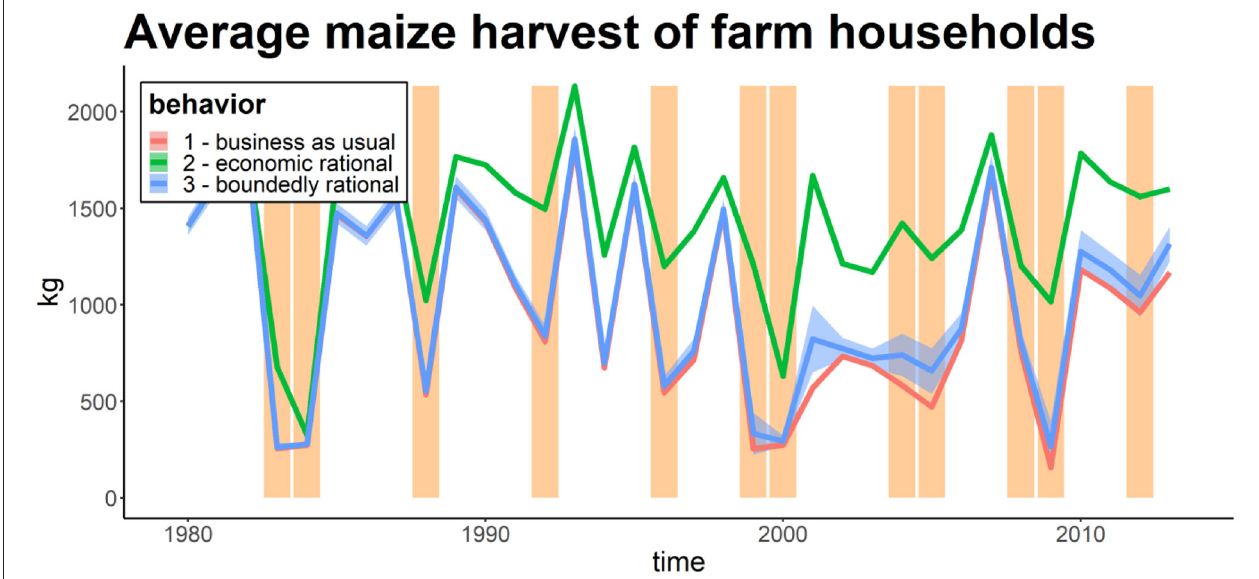
FIGURE 4 | Average annual maize harvest of the modeled households in kg/year for three behavioral scenarios: no adaptation decisions (BAU), economic rational (EUT), and bounded rational (PMT). Drought years (SPEI3 value in crop season < − 1) are visualized as vertical orange bars. The shaded blue area show the variance among 48 bounded rational model runs, a result of the variety in weights of the PMT